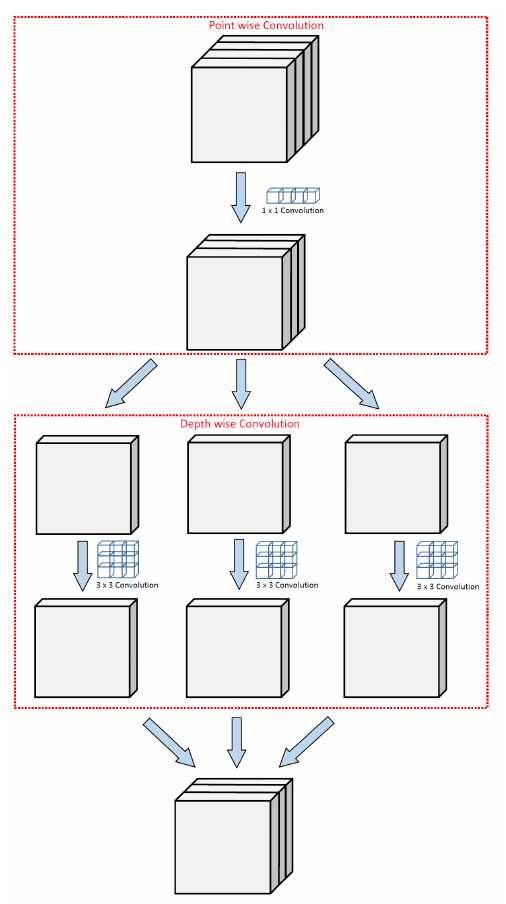
Figure 2. Illustration of modified depthwise separable convolution in Xception network Fine-tuning of the pre-trained Xception model is carried out by unfreezing the top five Xception blocks while keeping other bottom layers frozen to extract the most relevant and detailed features from dermoscopic images. Fine-tuning is performed on the middle flow and an exit flow of Xception network architecture, as shown in Figure 3. The separable convolution layers in the middle flow are retrained followed by exit flow, and weights are updated to extract relevant features. After global average pooling, these extracted features are passed to the top model containing four fully connected layers with 1024, 512, 256, and 128 units, respectively, each with ReLU activation and an output layer with sigmoid activation for binary classification.